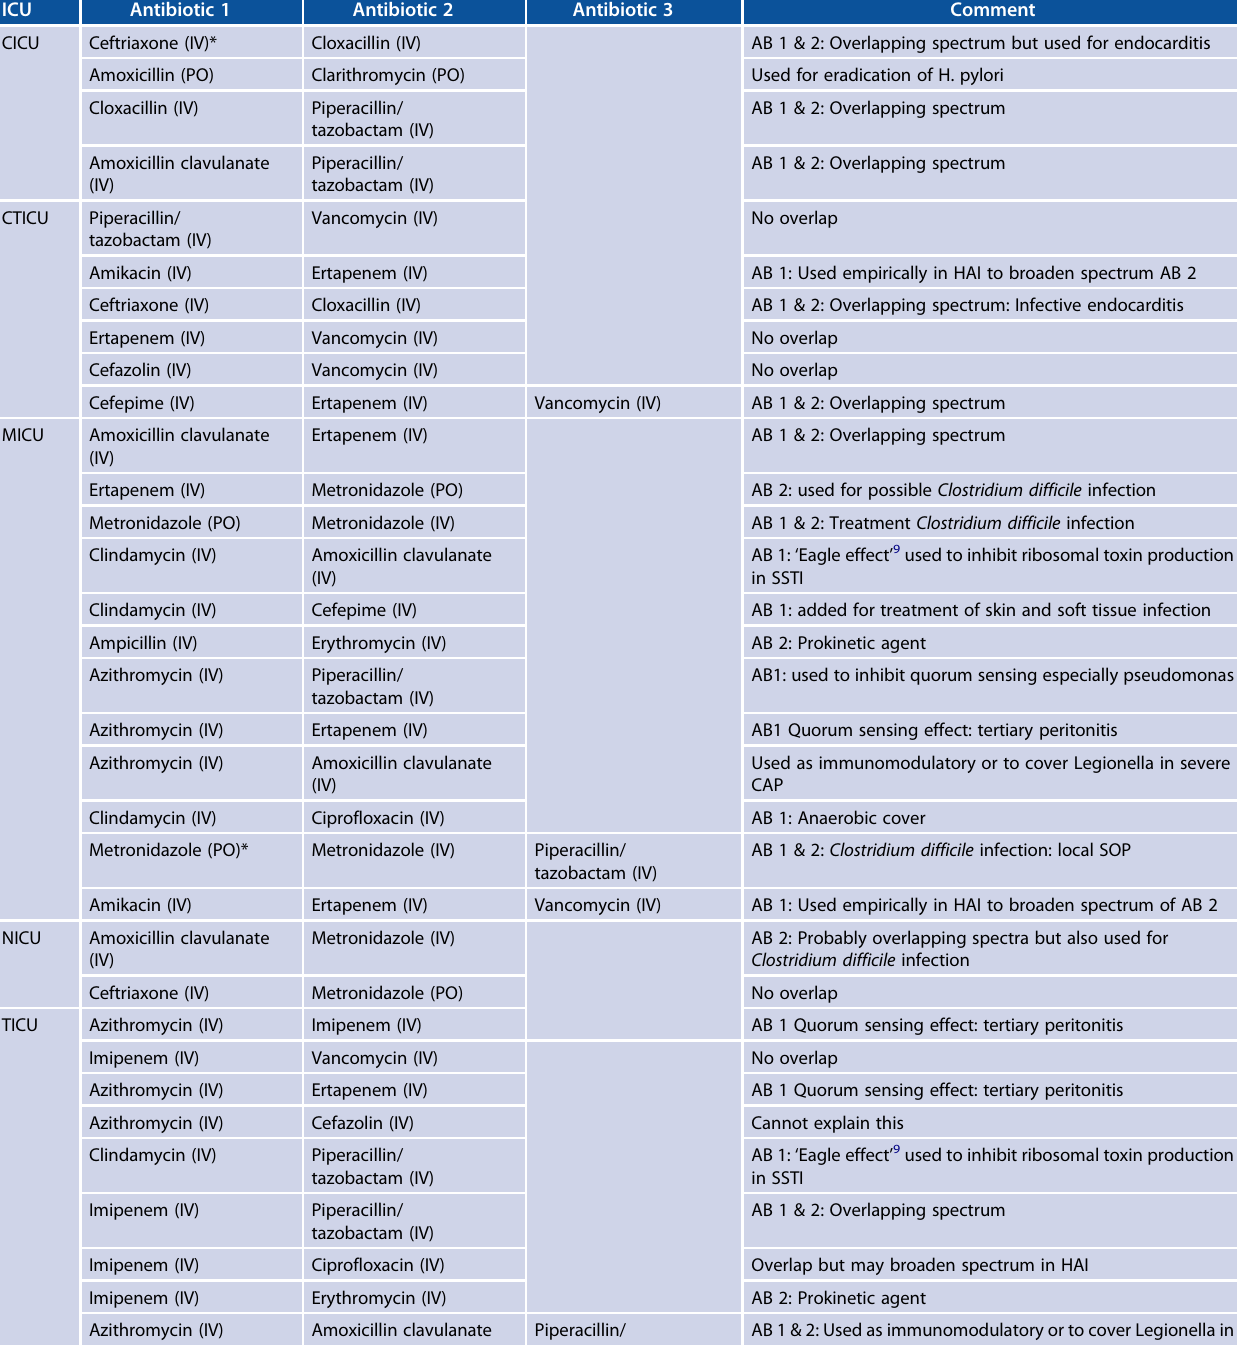
Table 3: Concurrent administration of two or three antibiotics per ICU